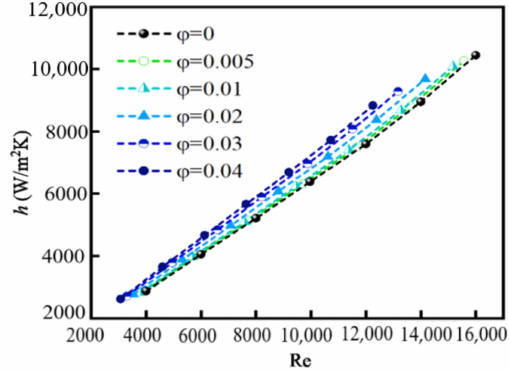
Figure 13. Relationship between h and Re for different ϕ .